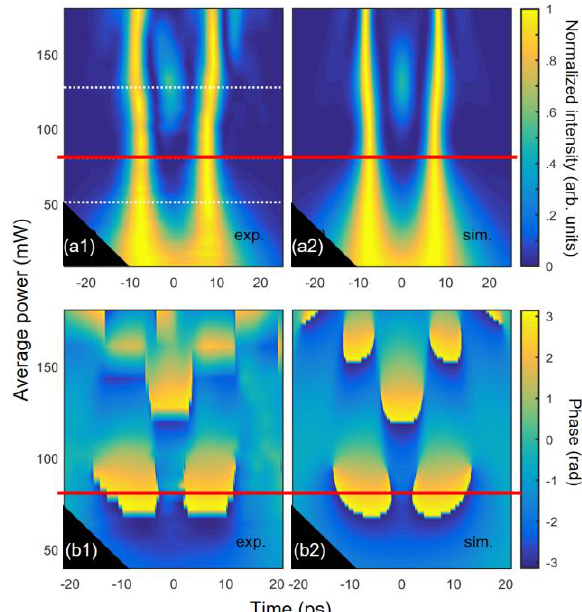
Fig. 2. Evolution of the output temporal intensity and phase profiles (panels a and b, respectively) of the waveform as a function of the initial average power for a fixed propagation length of 3.6 km. Experimental results (panels 1) are compared with numerical simulations (panels 2). Intensity profiles are normalized by the peak- power. The red horizontal line strands for the results detailed in Fig. 3.